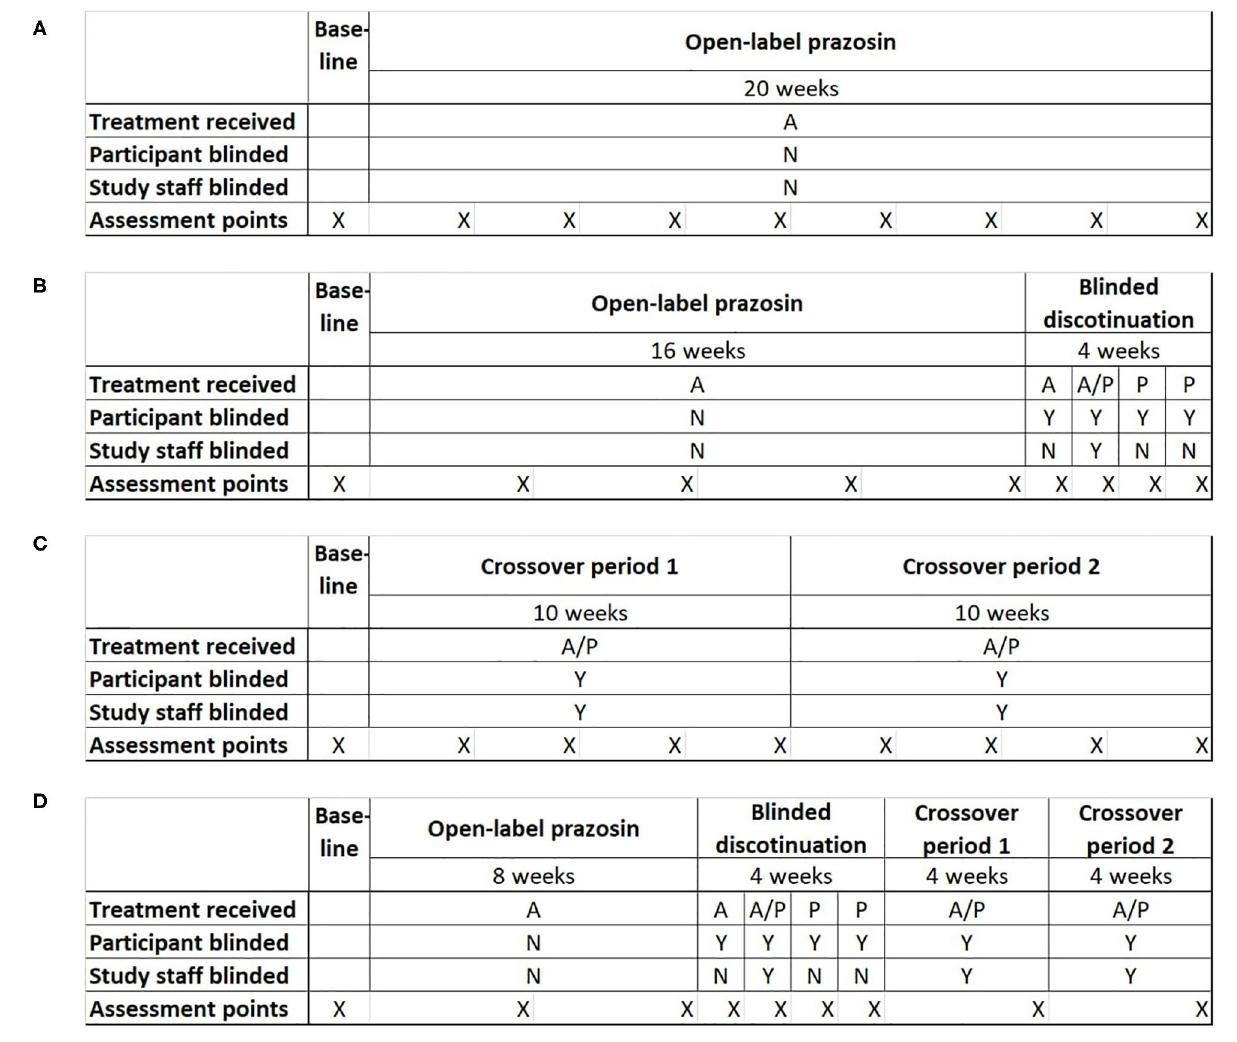
FIGURE 2 | Four potential clinical trial designs that were compared on their ability to detect a relationship between a biomarker measured at baseline and response to treatment with the pharmacotherapeutic agent prazosin. Trial designs were matched in duration and the number of evaluation points. (A) Open-label trial design: All participants receive open-label prazosin throughout the trial. (B) Open-label followed by blinded discontinuation design: All participants receive active drug for 16 weeks, then enter a 4 week blinded discontinuation block. During the blinded discontinuation block, all participants receive active drug during the first week and placebo during the last 2 weeks, such that only the participant is blinded to treatment condition during these weeks; the treatment condition during the second week is randomly assigned and a double blind is maintained during this week. (C) Traditional crossover trial design: Participants are randomized to 10 weeks on active drug followed by 10 weeks on placebo, or the reverse. (D) Proposed N-of-1 trial design: all participants begin with an 8 week open label period, then enter a 4 week blinded discontinuation period, then complete 8 weeks of crossover. There are two independent randomization points—whether the participant is on active drug (A)